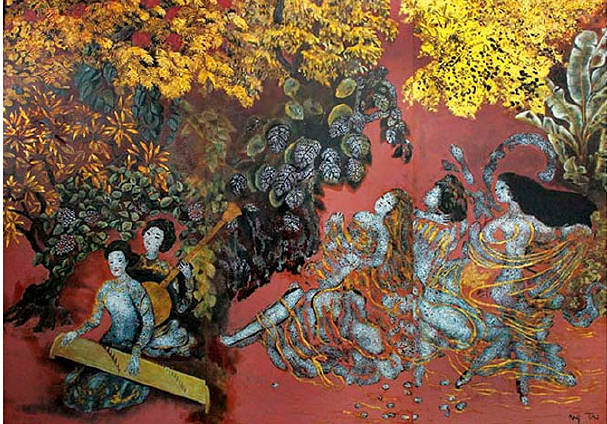
Figure A22. Trong vuon —Nguyen Gia Tri. Auctioned at Larasati, July 2015. The image was sourced from website soi.today (Long 2015).